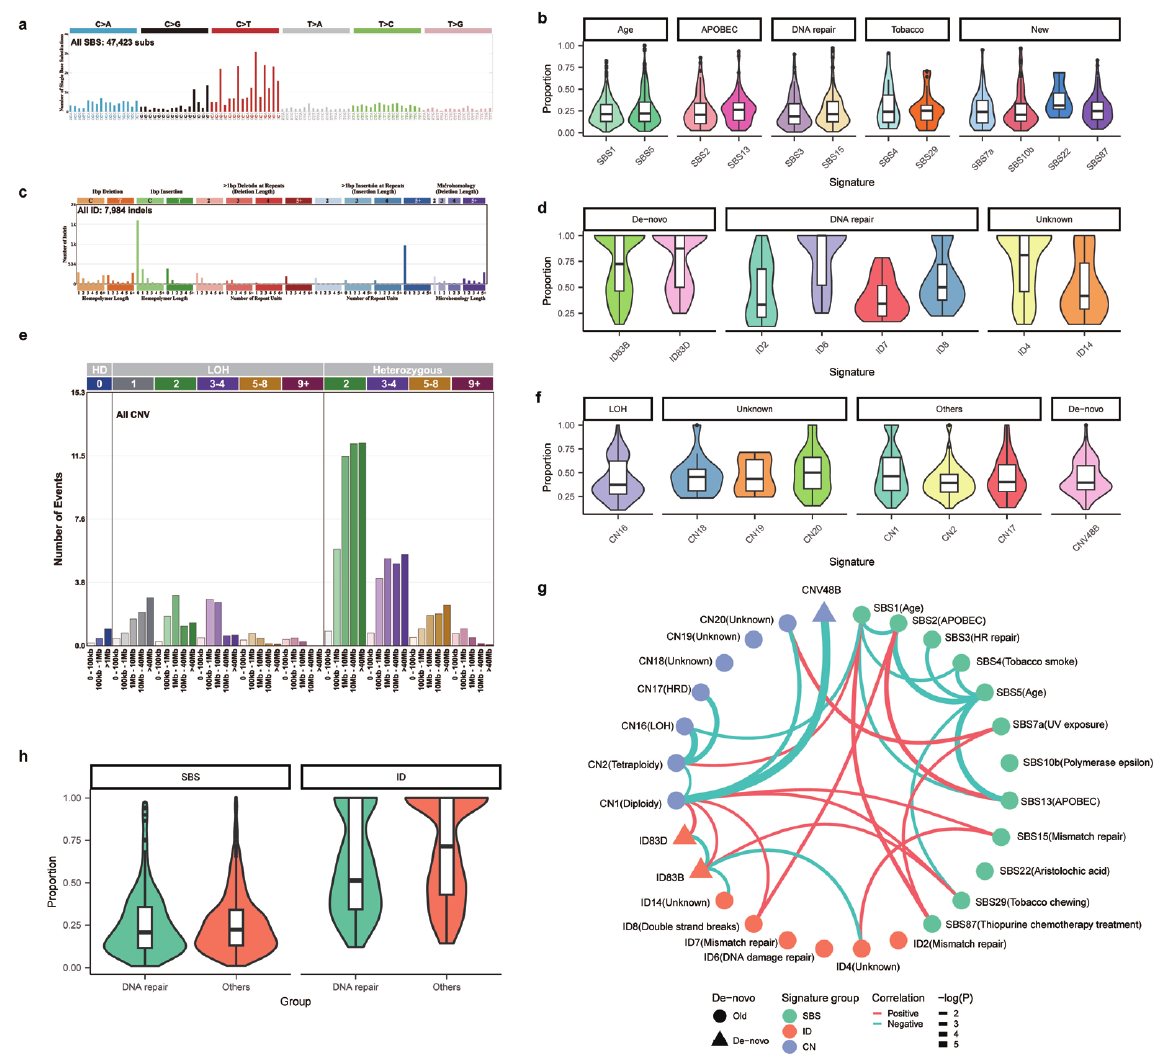
Figure 4. Mutational signatures across the NPC cohort. ( a ) The overall mutational landscape at the single-base level for the NPC cohort. ( b ) Contributions of different SBS signatures in the NPC cohort. ( c ) The overall indel landscape in the NPC cohort. ( d ) Contributions of different indel signatures in the NPC cohort. ( e ) The overall CNV landscape for the NPC cohort. ( f ) Contributions of different CNV signatures in the NPC cohort. ( g ) Correlation plot for different signatures. Red indicates positive correlation and blue indicates negative correlation. Line widths mark the significance of the mutual correlation. ( h ) Contribution of DNA repair signatures vs. other signatures.